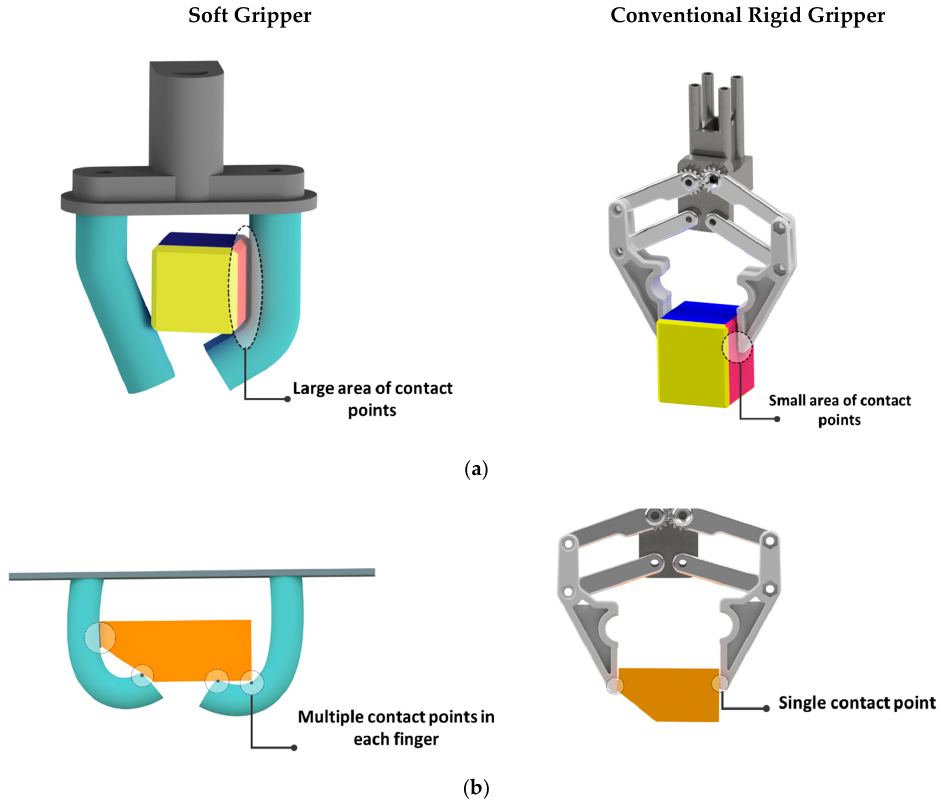
Figure 1. Comparison of the grasping performance of a soft and a conventional rigid gripper. Soft grippers have advantages including ( a ) large-area contact points and ( b ) multi-touch contact points at the same time.